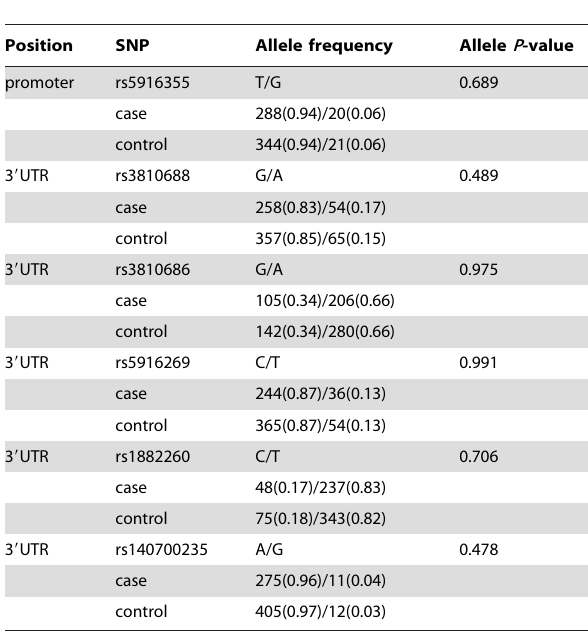
Table 1. The distribution of allele frequencies for 6 SNPs in NLGN4